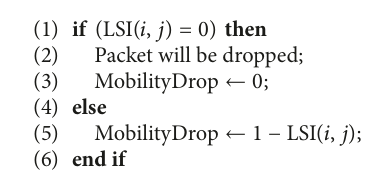
Table 2: Simulation